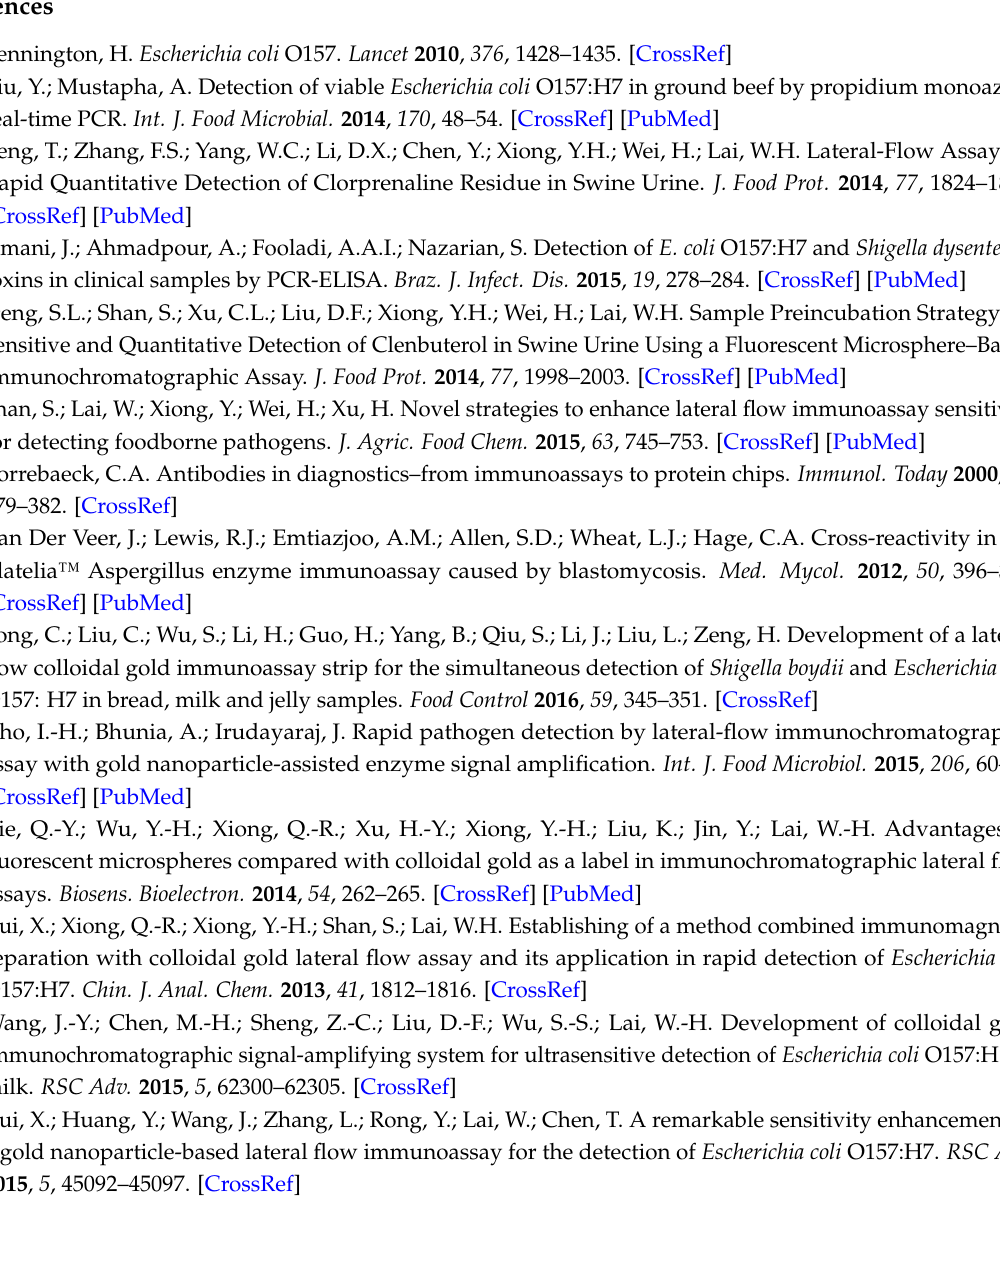
Figure S1: Detection results of the Au-LFIA test strips, Figure S2: CHROmagarTM plates used to isolate bacteria from the enrichment broth. (A) E. coli O157:H7. (B) Cross-reactive bacterium, Figure S3: Identification results of the cross-reactive bacterium by API 20E, Supplementary materials 4: Nucleotide sequence of 16S RNA of Citrobacter